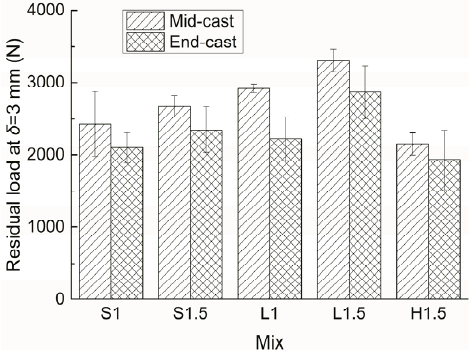
Figure 7. Residual loads of all UHPCs with two different casting positions.